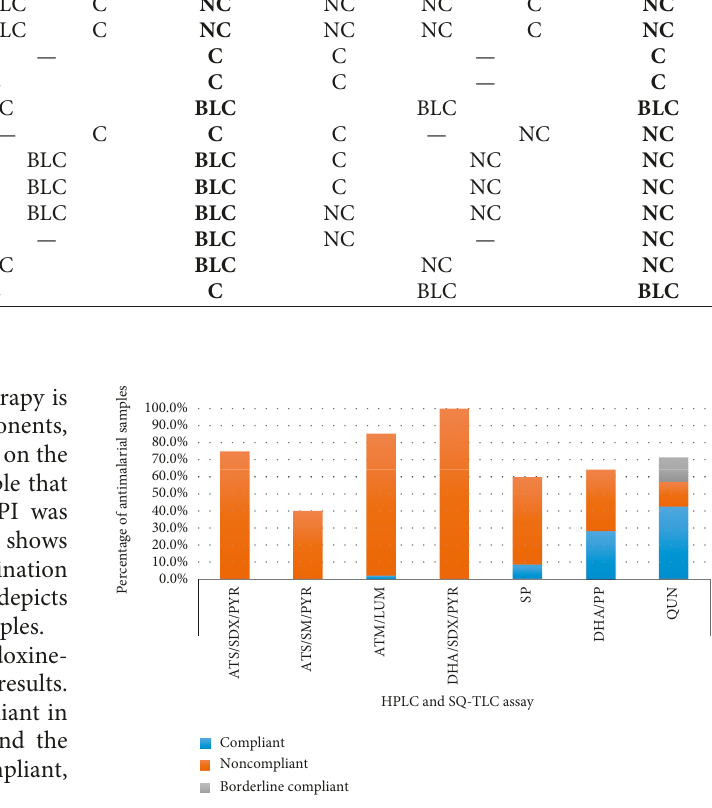
Figure 3: Antimalarial medicines with same results from SQ-TLC and HPLC